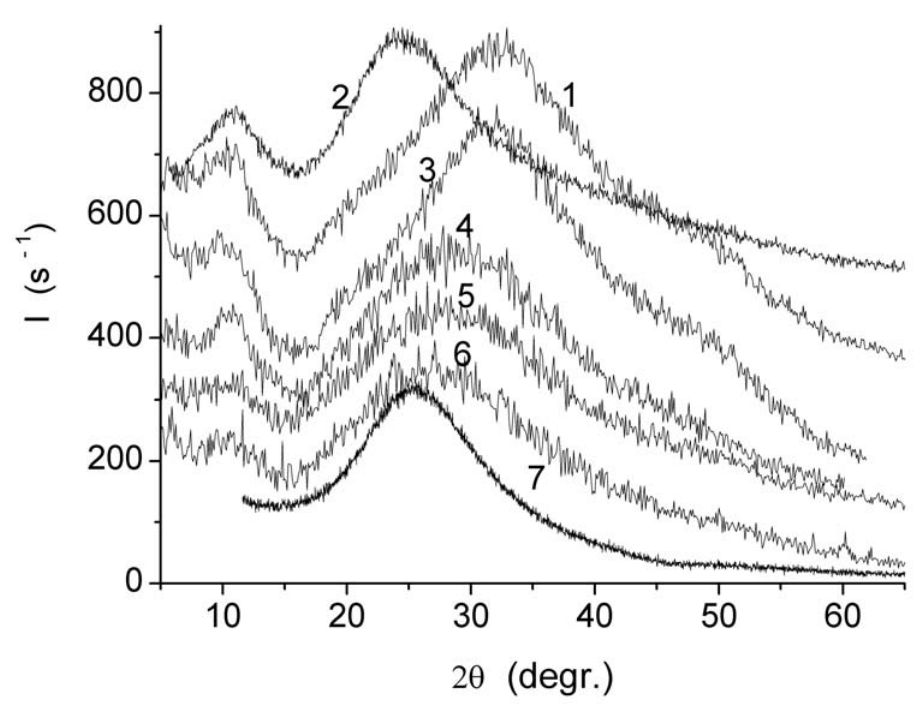
Fig. 5 XRD patterns of initial (curve 1) and air-dried RBCs (2), RBCs/A-300 at C A − 300 = 1 (3), 8 (4), 20 (5) and 30 wt.% (6), and dry A-300